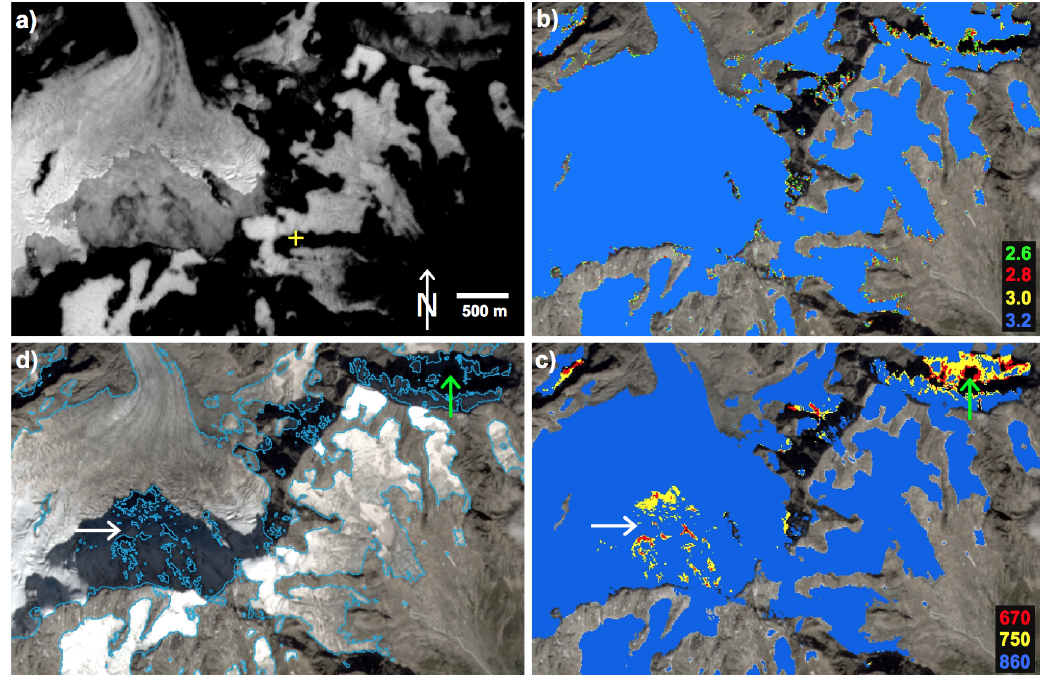
Figure 3. Results of the automated (clean ice) glacier mapping and threshold selection: (a) band ratio MSI band 4 / MSI band 11 (red / SWIR). (b) Glacier classification results using different thresholds. The lower values add some additional pixels, in particular in shadow regions where the threshold is most sensitive. (c) Blue band threshold to remove wrongly classified rock in shadow. The highest value has been used, resulting in a good performance in the left part of the image (white arrow) and a bad one to the right (green arrow), where correctly classified ice in shadow is removed. (d) Final outlines (light blue) on top of the Sentinel-2 image in natural colours. The yellow cross to the lower right of the centre of panel (a) is marking the coordinates 45.87 ◦ N and 7.0 ◦ E (image source: Copernicus Sentinel data